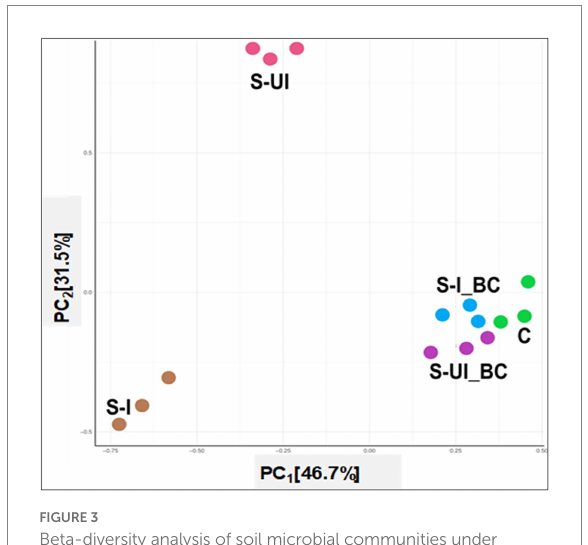
FIGURE 2 Residual concentrations (mg Kg − 1 ) of metribuzin (MB) and its metabolites i.e., desamino-metribuzin (DA), diketo-metribuzin (DK) and desamino-diketo-metribuzin (DADK) in soil under various treatments at 30, 60 and 90 days after incubation (DAI).